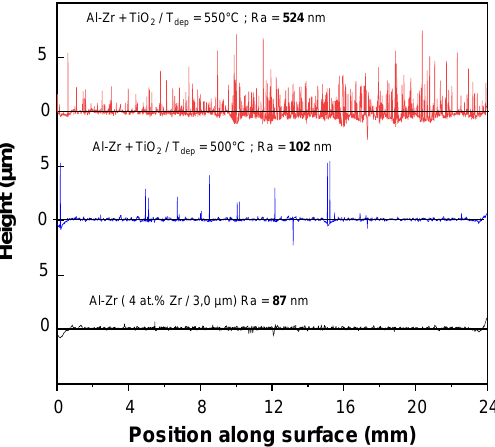
Figure 2. Surface roughness patterns measured 25 mm along the surface.